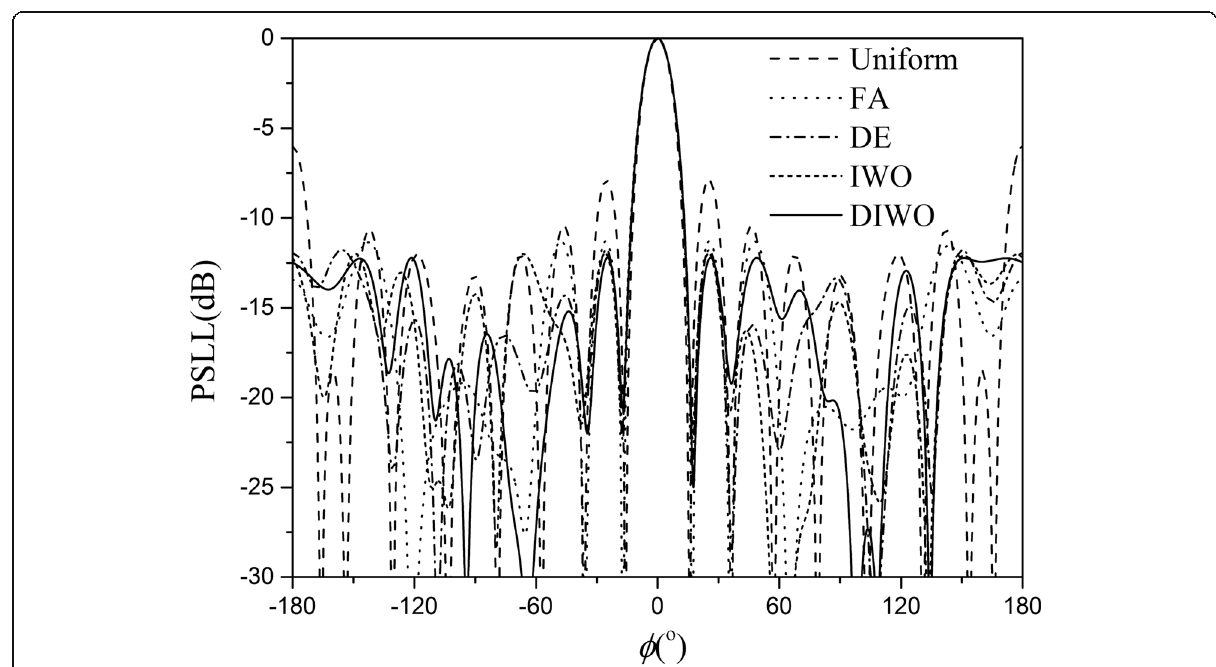
Fig. 6 Radiation pattern of elliptical antenna array with 20